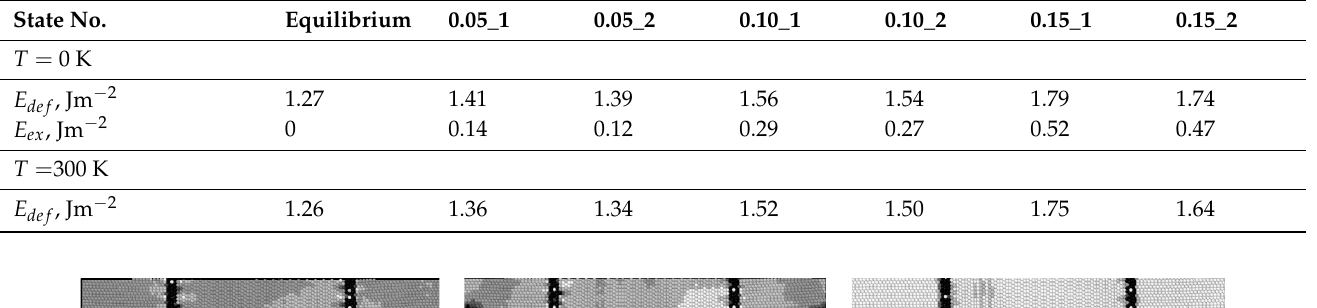
Table 3. Energies of grain boundaries in equilibrium and nonequilibrium nanocrystals at zero and room temperatures [121].